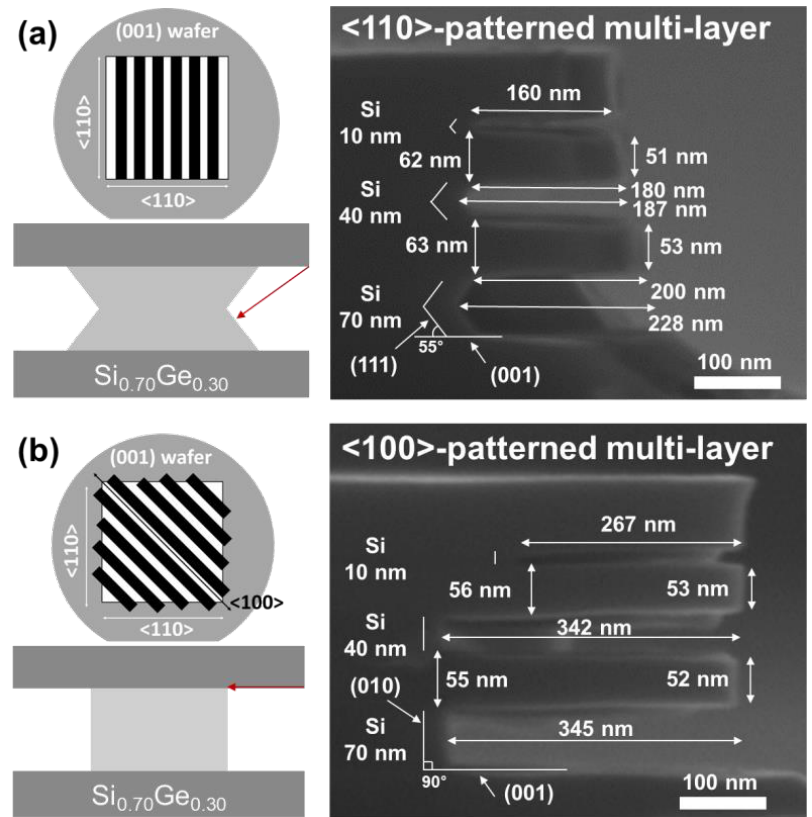
Figure 9. Cross-sectional transmission electron microscopy image of Si 0.7 Ge 0.3 /Si/Si 0.7 Ge 0.3 multi-layer after selective etching of Si in TMAH.